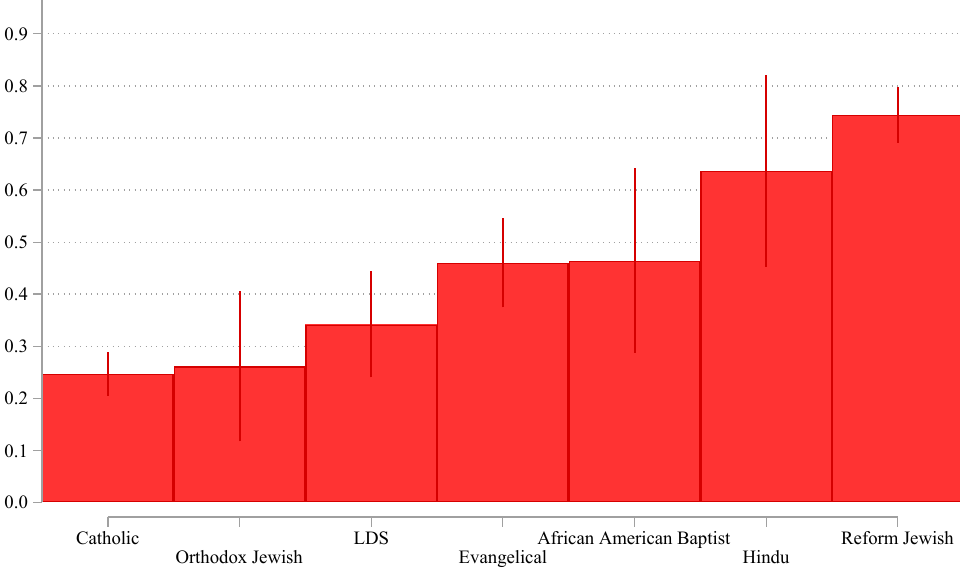
Figure 1. Predicted probabilities of expectations of attending a mix of online and in-person religious services (1) vs. in-person only (0) after the pandemic by congregation type (n = 1116). Note: The depiction is based on the logistic regression of model 1 and controls for baseline demographic and socioeconomic factors as well as physical health and other aspects of religiosity. The predicted probabilities are calculated when treating the control variables at their mean values. 95% confidence intervals of the predictions are shown. Mental Health in Congregations Study, 2020.